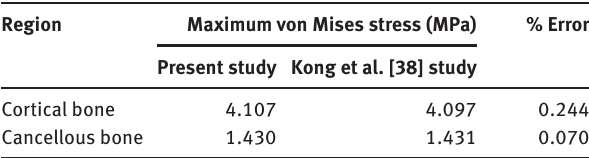
Table 3: A comparison between the results in present study and those reported in Ref. [38] under the same simulation.